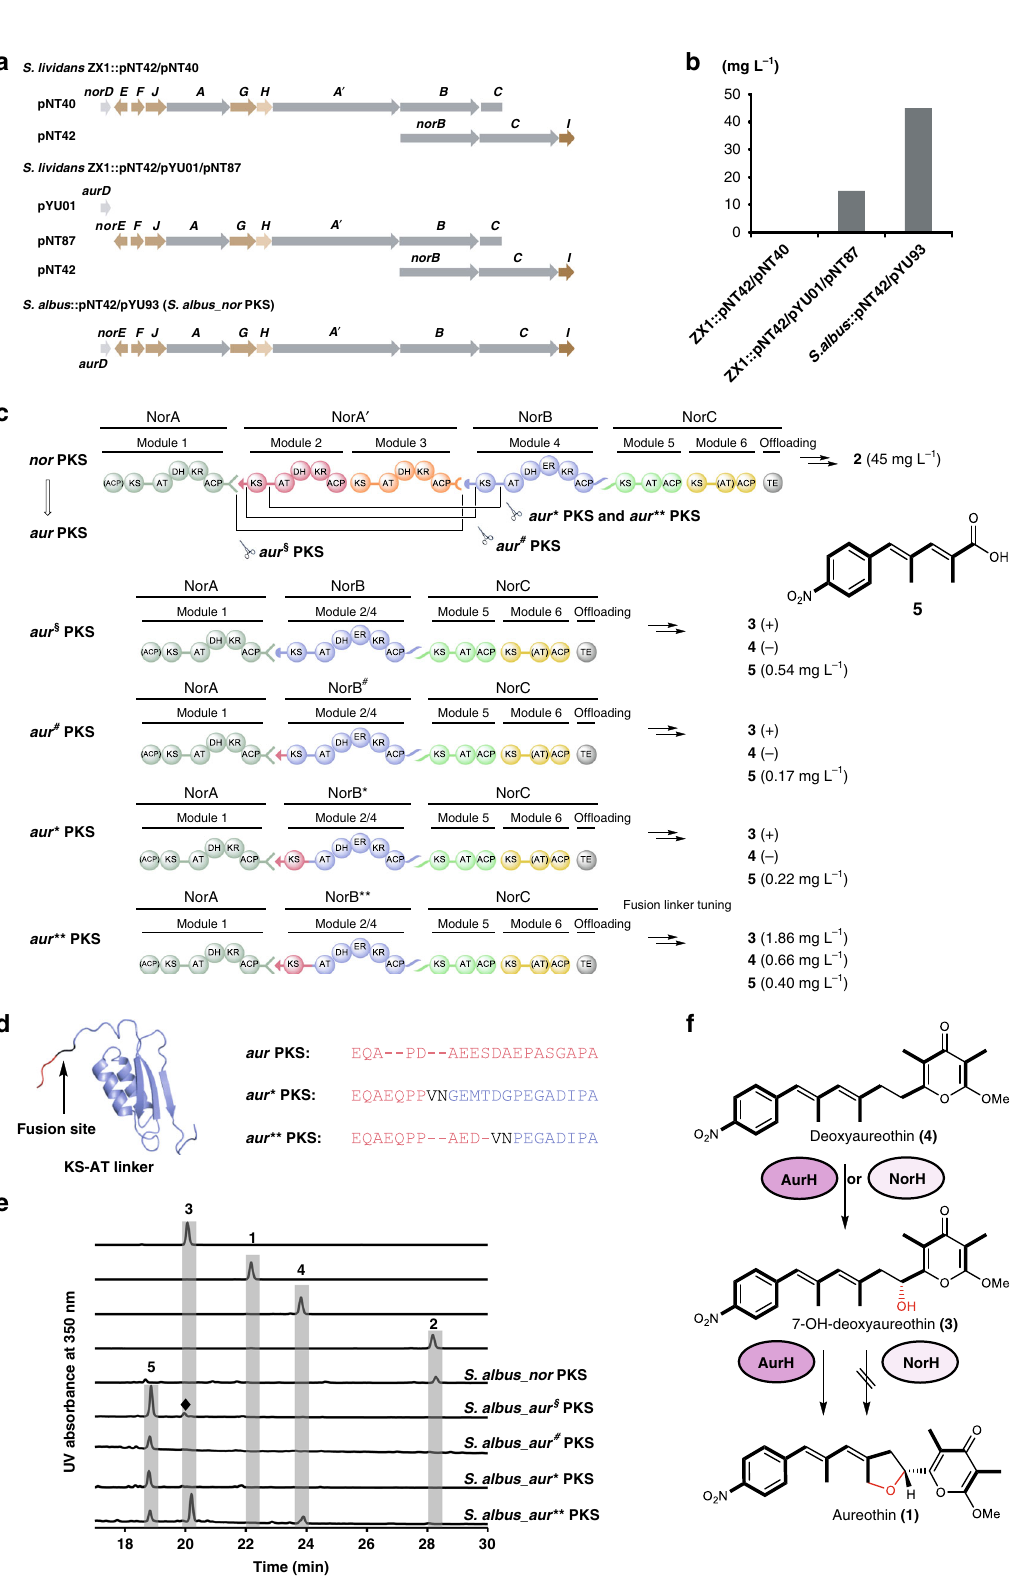
NorH partly transformed 4 into 3 , and it was not capable of into the Δ aurH mutant by triparental conjugation, and the forming 1 (negative control) All Δ aurH mutant strains metabolic pro fi les of the individual transformants were mon- complemented with point-mutated NorH variants showed the itored by HPLC-MS (Fig. 4b and Supplementary Fig. 13). same chemotype. The only difference was a slightly increased 3 -to The Δ aurH mutant produces exclusively 4 ; when complement- - 4 ratio for NorH-V71L and NorH-T292P (Fig. 4b and ing the mutant with native AurH, 4 is readily converted into 1 Supplementary Fig. 13). These results indicate that these (positive control). In contrast, the mutant complemented with NATURE COMMUNICATIONS| (2019) 10:3918